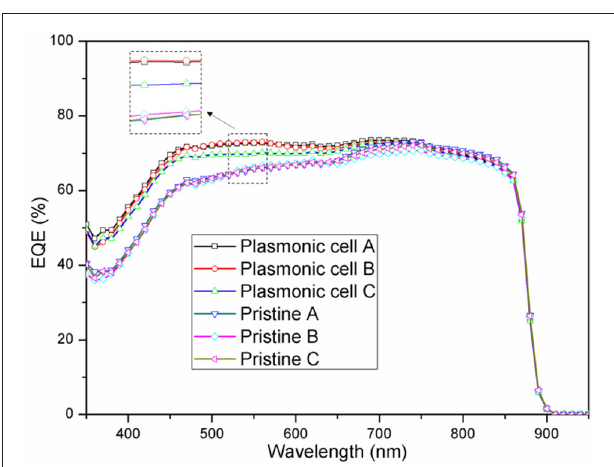
FIGURE 7 | External quantum efficiency (EQE) of pristine cells and plasmonic cell with different Au nanostar